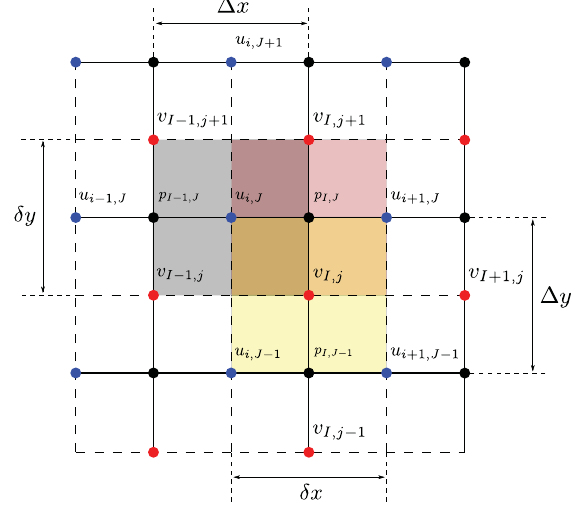
Figure 5. One cell for the x momentum equation (grey, u i,J ), one for the y momentum equation (yellow, v I,j ) and one for the conti- nuity equation (pink, p I,J ). All three cells have equal dimensions and